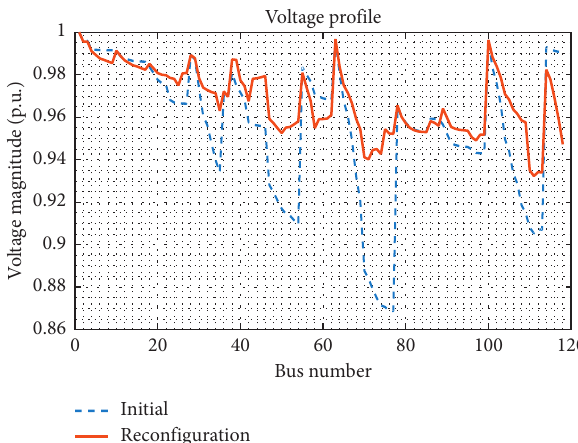
Figure 12: Voltage profile for the 119-bus system before and after reconfiguration.